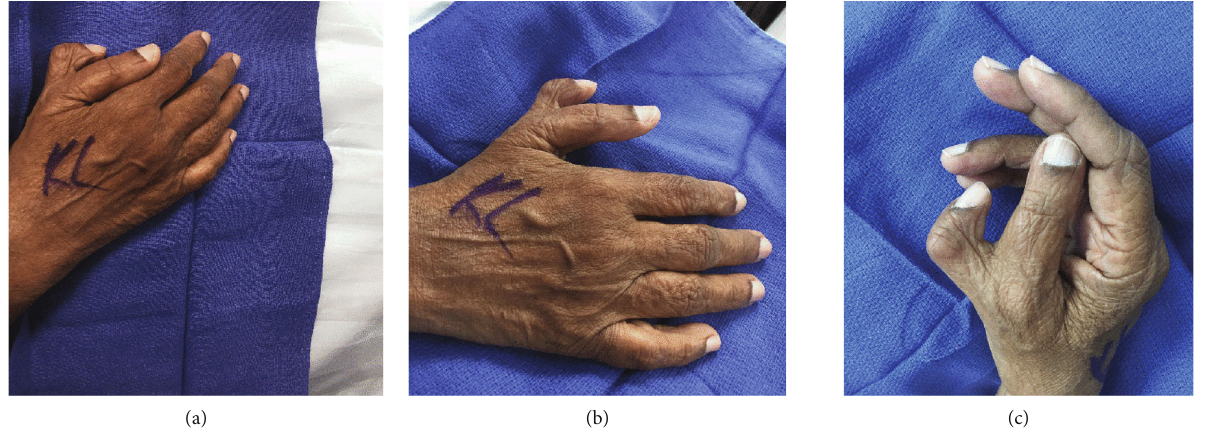
Figure 1: Preoperative clinical photographs demonstrating preaxial polydactyly of the patient ’ s right thumb. (a) Oblique view. (b) Dorsal view. (c) Lateral